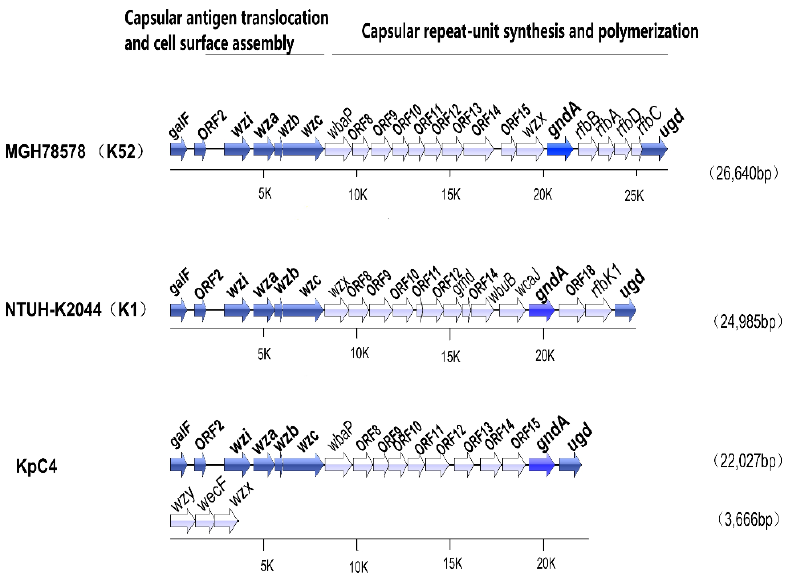
Figure 5. Comparison of capsular polysaccharide synthesis (cps) gene clusters between K. pneumoniae KpC4, NTUH-K2044 (K1), and MGH78578 (K52). The locations and orientations of the open reading frames (ORFs) are indicated by arrows. ORFs are cited in order, ORFs with homologs are cited by putative gene names, and those without homologs are cited as ORFs and are numbered. Starting from galF , considered to be no. 1 (ORF** in KpC4, ORF in K2044, and ORF* in MGH78578). Solid arrows refer to ORFs with significant similarity (the aligned genes with scores > 200 and expect values < e − 50 in the BLASTP search), and unshaded arrows indicate the ORFs with low similarity between any two strains (the homolog could not be found even when the expected threshold was set to be 10 in the BLASTP search). Nos. beneath each axis denote positions in kilobases. The cps loci of K2044(K1), KpC4, MGH78578(K52) encode different serotypes, and